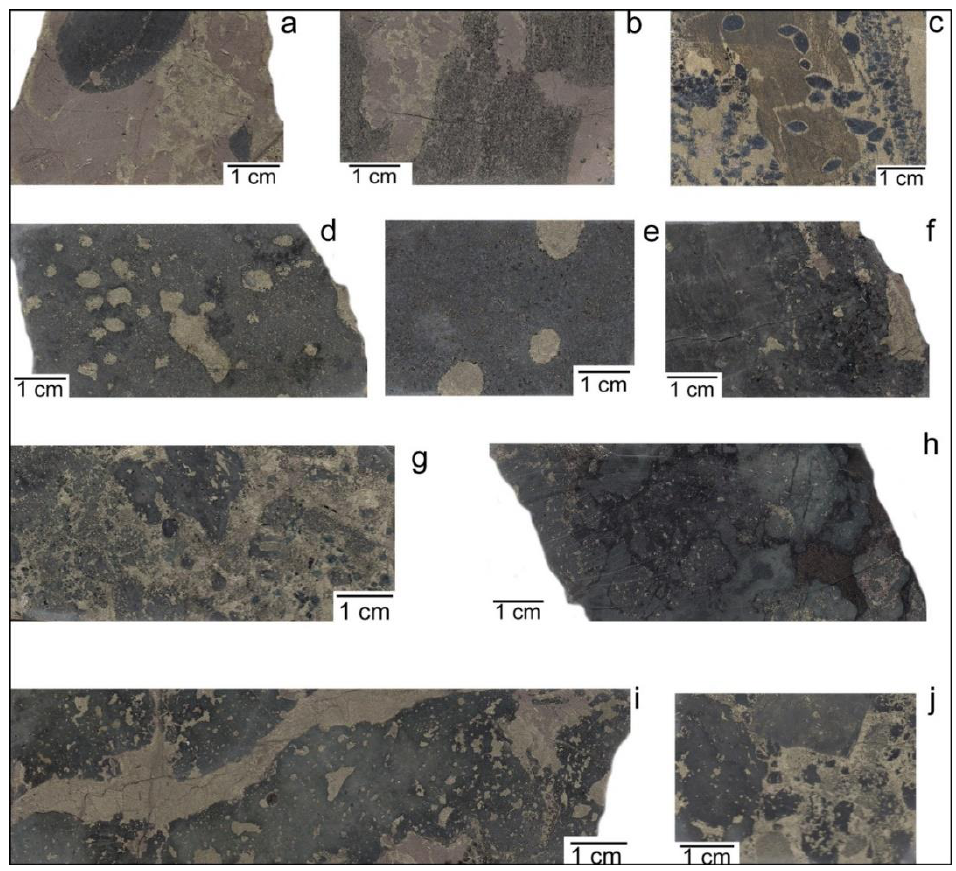
Figure 2. Studied ore types of the Oktyabrsk deposit. ( a – c )—massive ores (( a , b )—pyrrhotite dominated, ( c )—chalcopyrite dominated); ( d – f )—disseminated ores (( d )—in contact gabbrodolerites, ( e )—in olivine-free gabbrodolerites, ( f )—in picrites); ( g – j )—veinlet-disseminated ores (pyrrhotite–chalcopyrite subtype) in carbonate skarns. In ( a – c ): pyrrhotite in groundmass with the emulsion phase